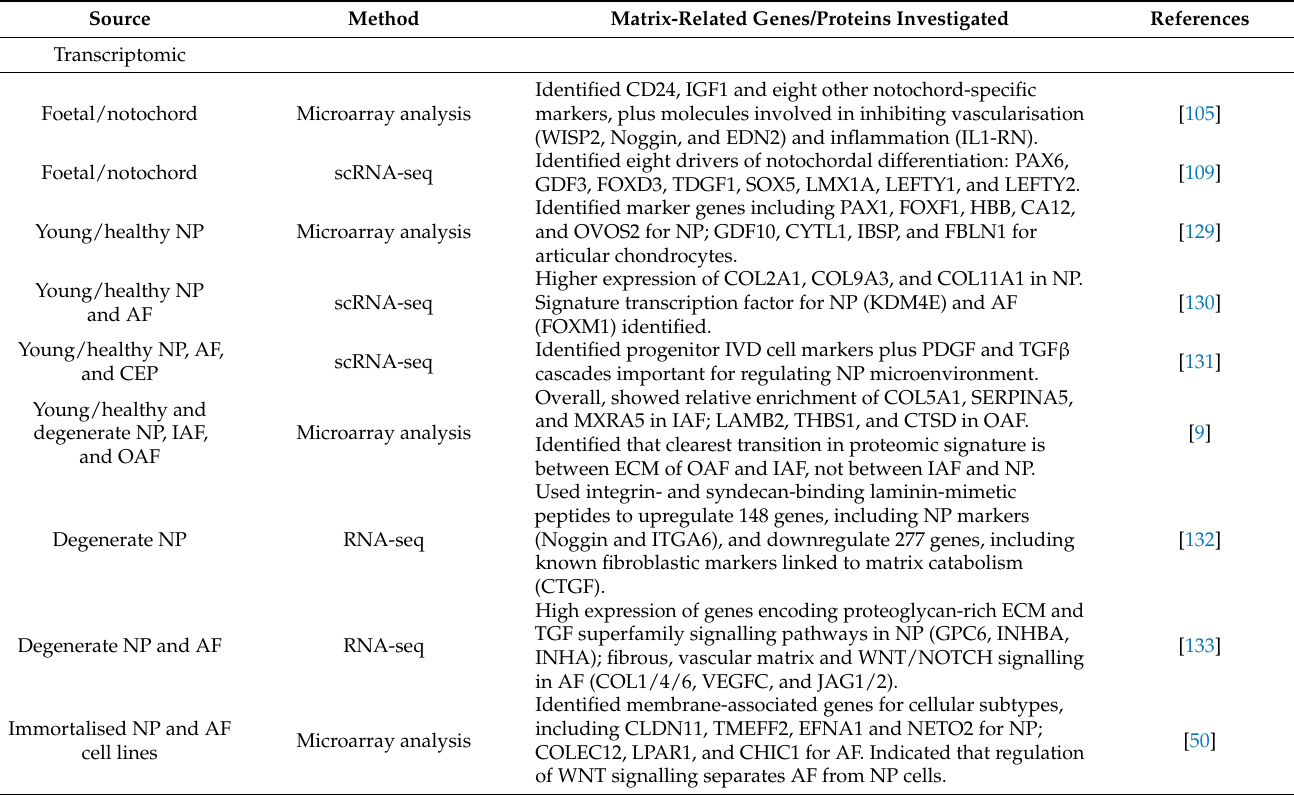
Table 2. Important matrix genes and proteins identified during IVD omics studies in